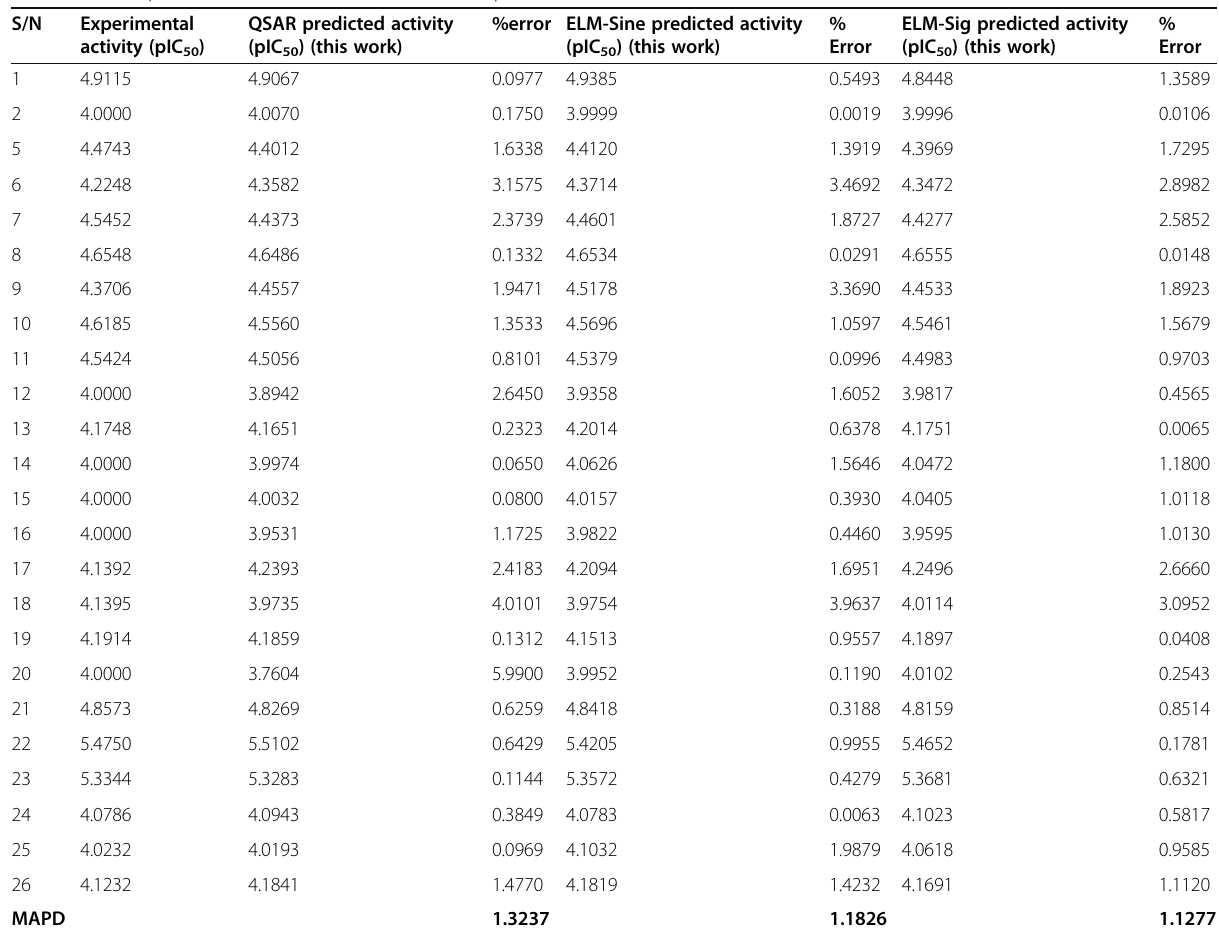
Table 10 Comparison of the estimates of the developed models S/N Experimental activity (pIC 50 )